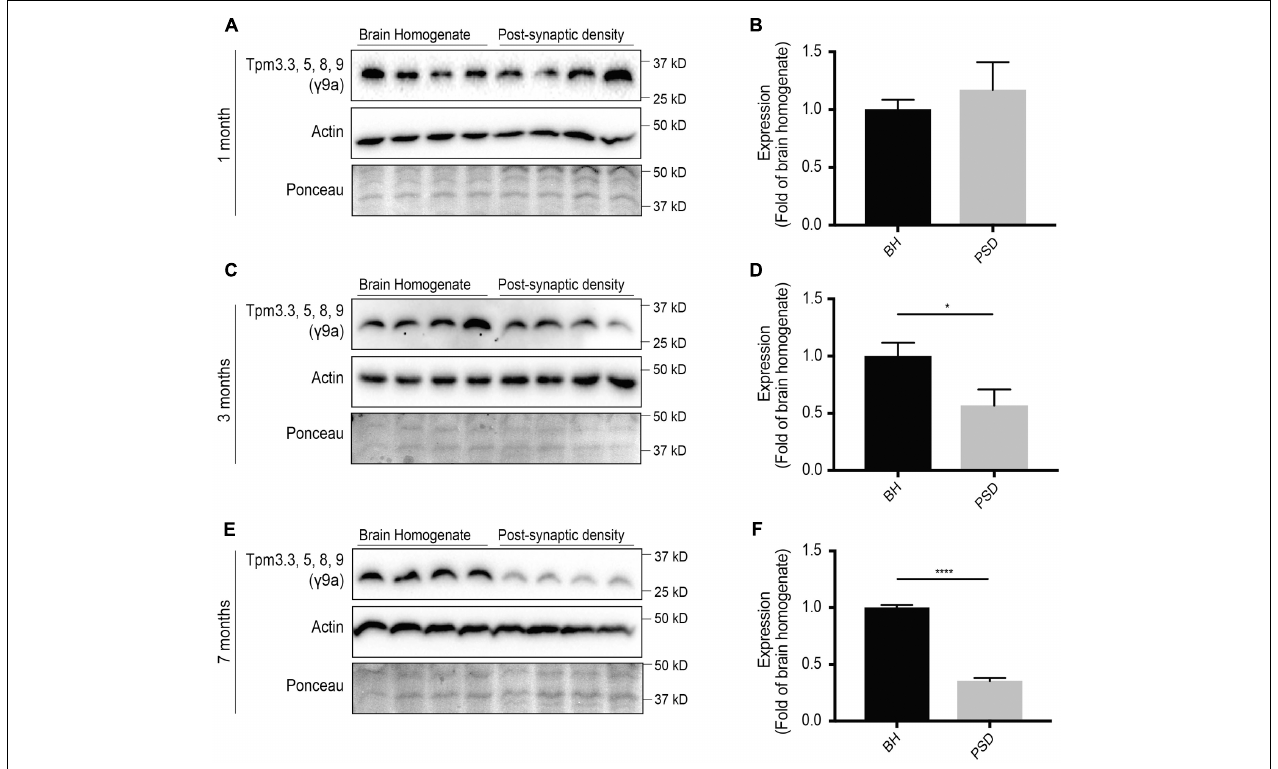
FIGURE 5 | Western blot analysis of expression profile of Tpm3 exon 9a-containing tropomyosin (Tpm) isoforms (utilizing the γ 9a mouse monoclonal antibody) in the brain homogenate (BH) and post-synaptic density (PSD) of wild type mouse brains. (A) Western blot of 1-month-old brain homogenate and PSD fractions. (B) Quantification of (A) normalized to expression in the brain homogenate. (C) Western blot of 3-months-old brain homogenate and PSD fractions. (D) Quantification of (C) normalized to expression in the brain homogenate. (E) Western blot of 7-months-old brain homogenate and PSD fractions. (F) Quantification of (E) normalized to expression in the brain homogenate. Total actin and Ponceau staining are used as loading controls. (mean ± SEM, n = 4, ∗ P < 0.05, ∗∗∗∗ P <